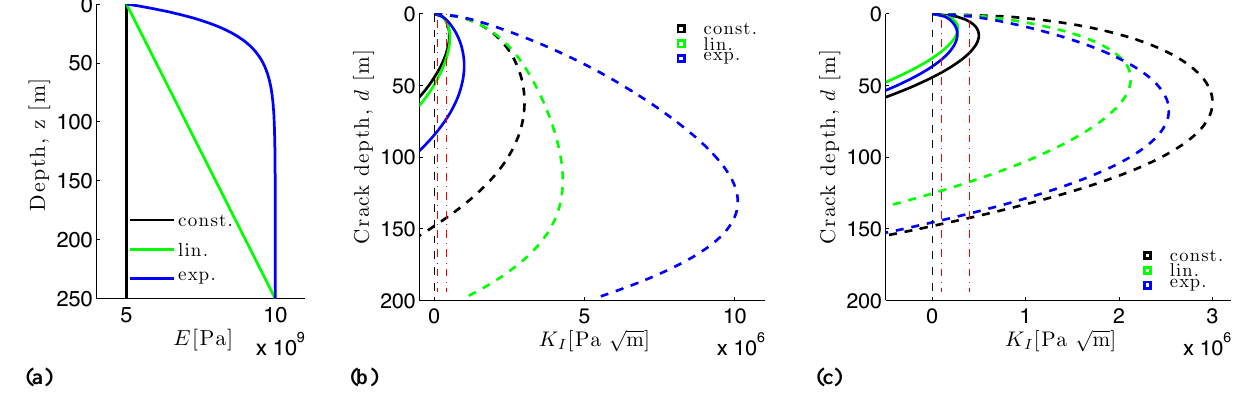
Fig. 7. (a) Simulated depth-dependent Young’s modulus functions. (b) Stress intensity factors resulting from different Young’s modulus profiles with surface stresses equal to previous simulations (drawn through line, 1u b = 100 kPa surface stress, dashed line, 1u b = 300 kPa surface stress). (c) Stress intensity factors resulting from different Young’s modulus profiles with resulting depth integrated tensile stresses equal to previous simulations (drawn through line, 1u b = 100 kPa depth integrated tensile stress, dashed line, 1u b = 300 kPa depth integrated tensile